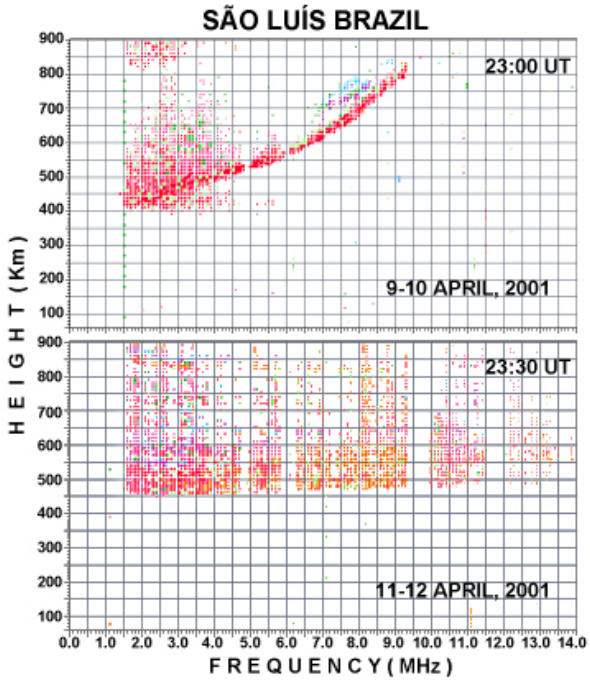
Fig. 2. An ionogram from 23:00 UT (20:00 LT) during a quiet control night (9–10 April 2001) (upper panel) and an ionogram for the storm night (11–12 April 2001) at 23:30